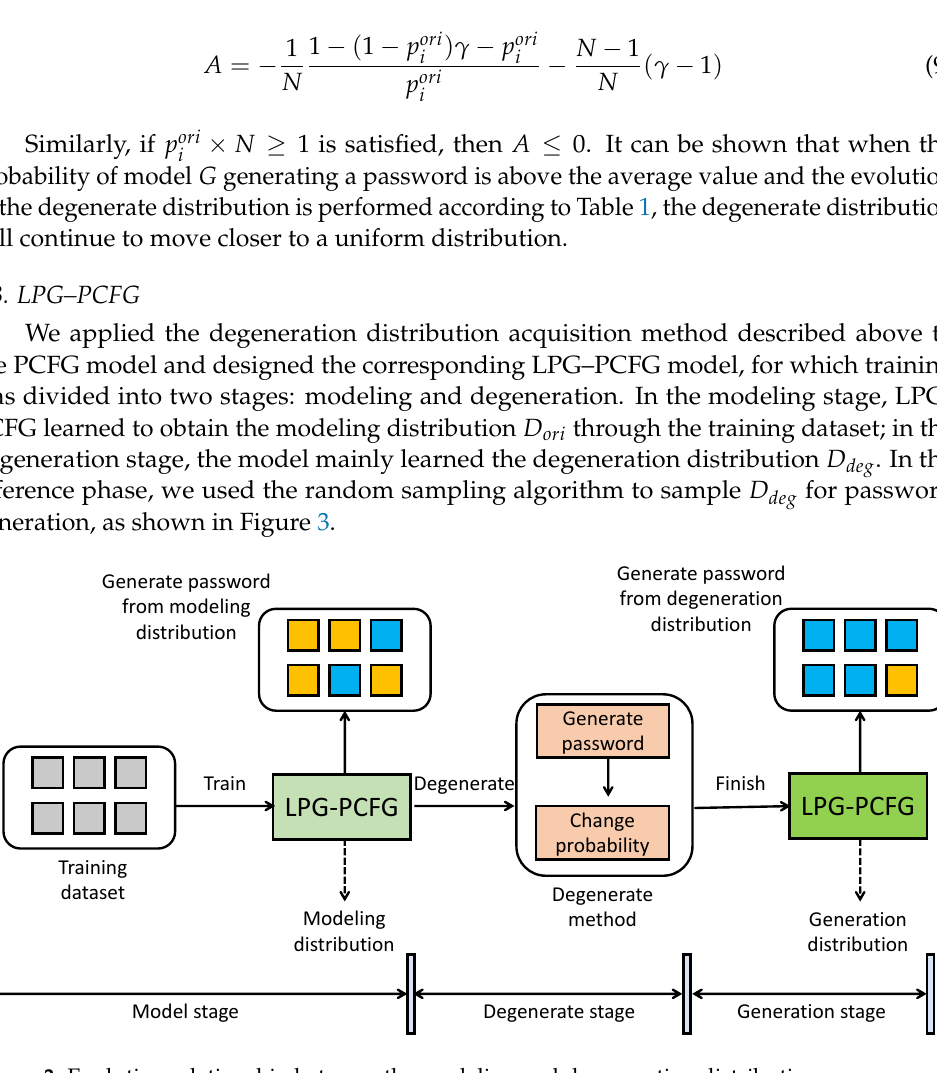
Figure 3. Evolution relationship between the modeling and degeneration